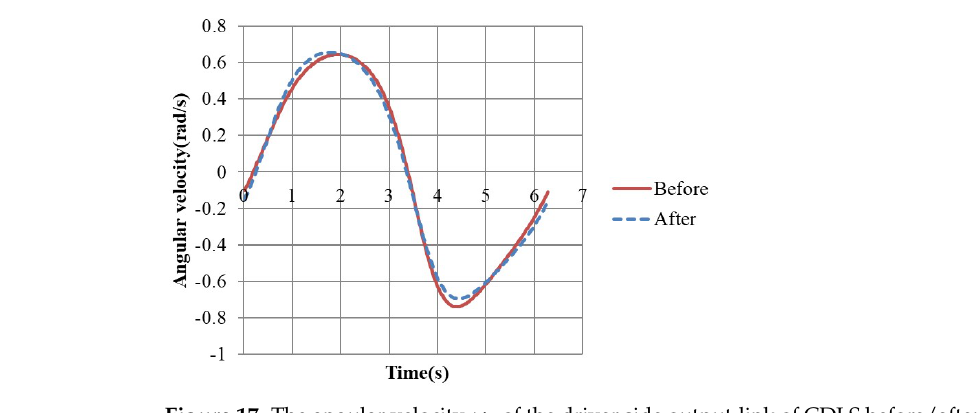
Figure 17. The angular velocity 6  of the driver side output-link of CDLS before/after DE opti-